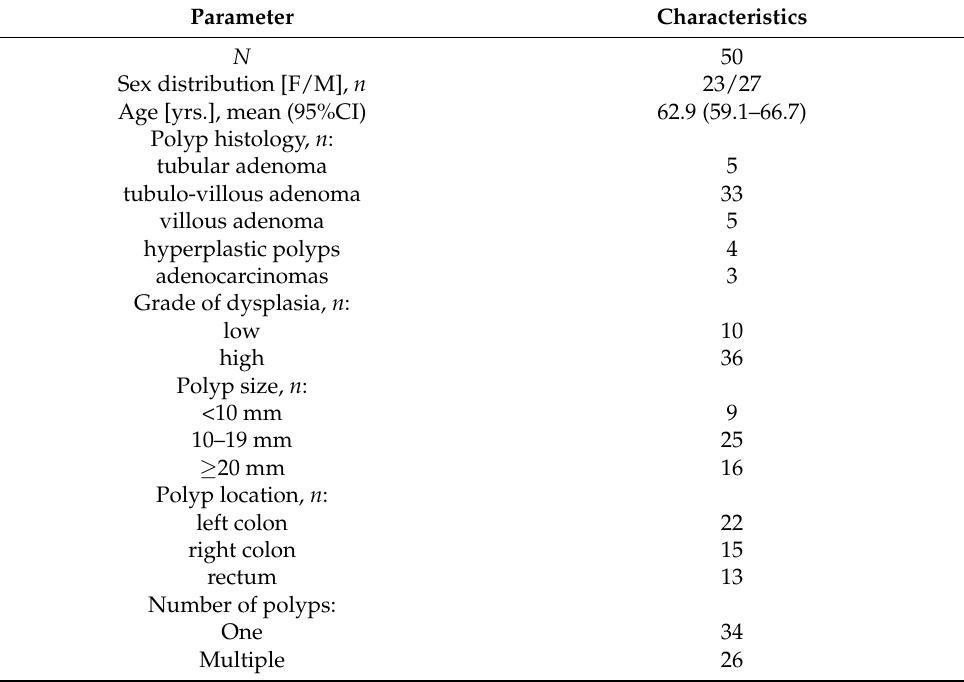
Table 1. Characteristics of patients with colorectal